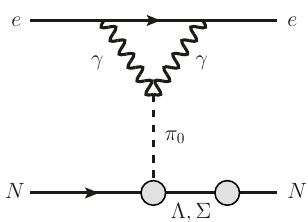
Figure 5 . Leading two-photon exchange contribution to the S-PS interaction in the SM. The grey blobs are strangeness changing interactions generated by the CKM